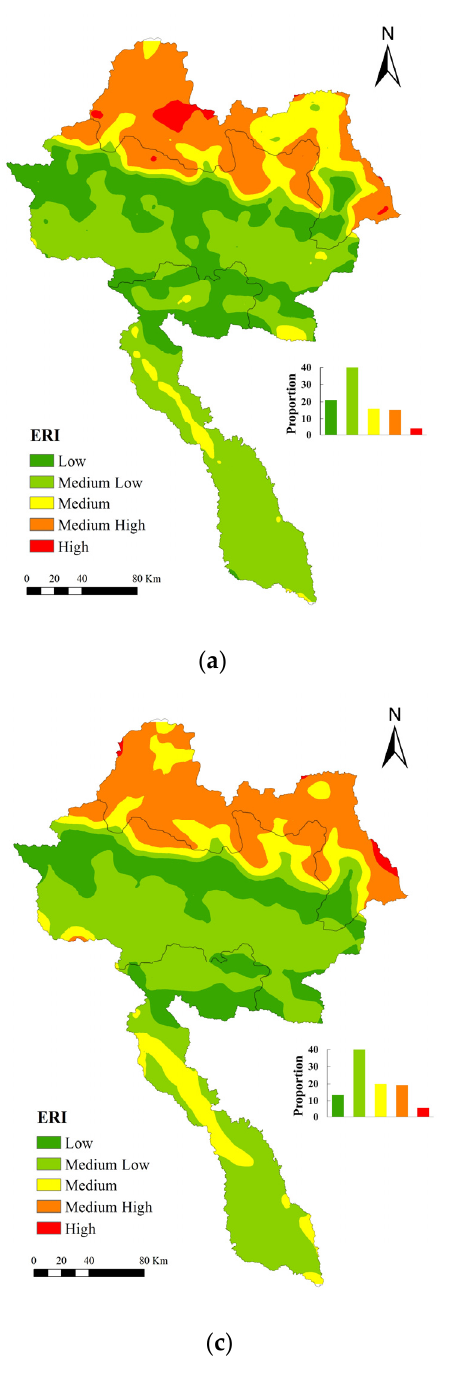
Figure 3. The spatial distribution of ecological risk index in Gandaki River Basin in 1990 ( a ), 2000 ( b ), 2010 ( c ) and 2020 ( d ). The inset histograms show the proportion of ERI with different class; the legends are consistent with the map legends.